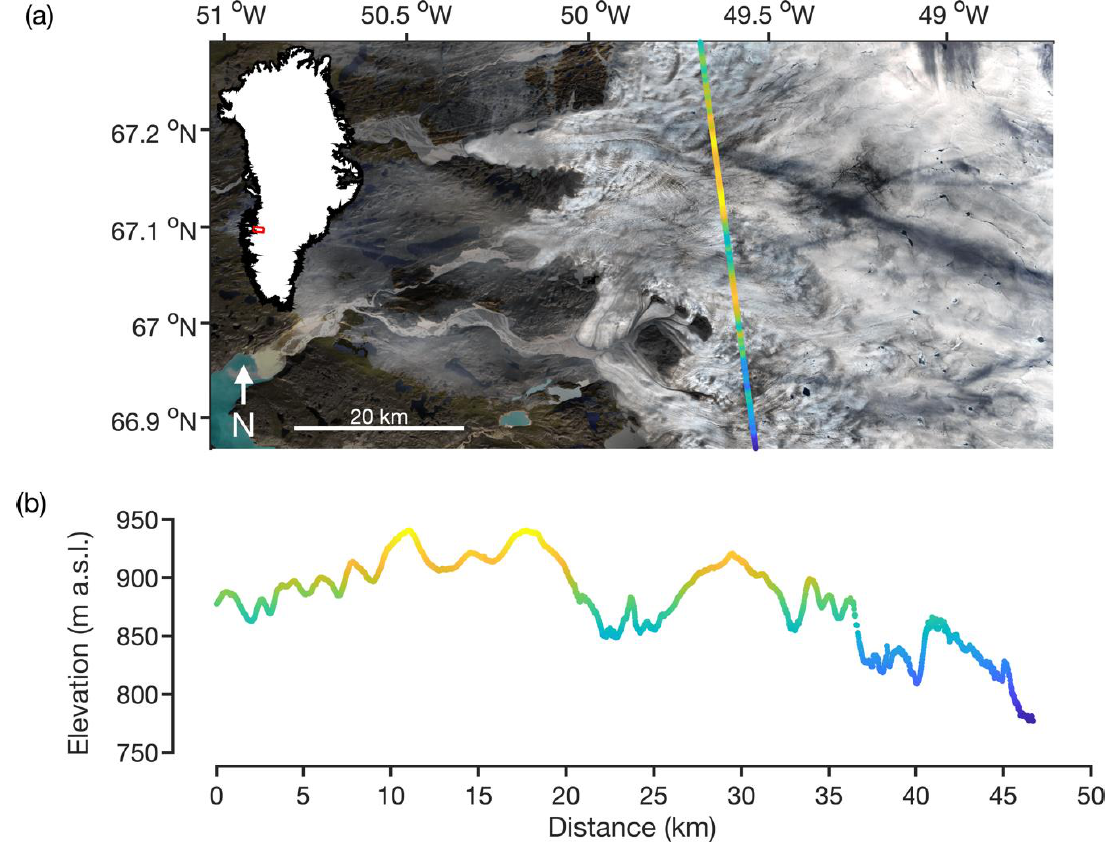
Figure 5. ( a ) Example of ATLAS/ICESat-2 Level-3A data product Land Ice Height, Version 1 (ATL06) [178], collected on 24 October 2018 in the Isunnguata Sermia and Kangerlussuaq catchments in the southwestern Greenland Ice Sheet ablation zone. Background image is Landsat 8 Operational Land Imager 30 m resolution image (RGB: band 4 (red), 3 (green), and 2 (blue)) collected on 24 August 2018. Inset is Greenland Ice Mapping Project (GIMP) ice mask [185] with red box showing extent of image area; ( b ) elevation profile for ground track profile 3, right beam (‘gt3r’), for the north to south track shown in ( a ), showing the rough, crevassed ice surface in the marginal ablation zone. ATL06 elevations represent mean surface elevation averaged along 40 m segments of ground track, posted at 20 m along-track spacing.